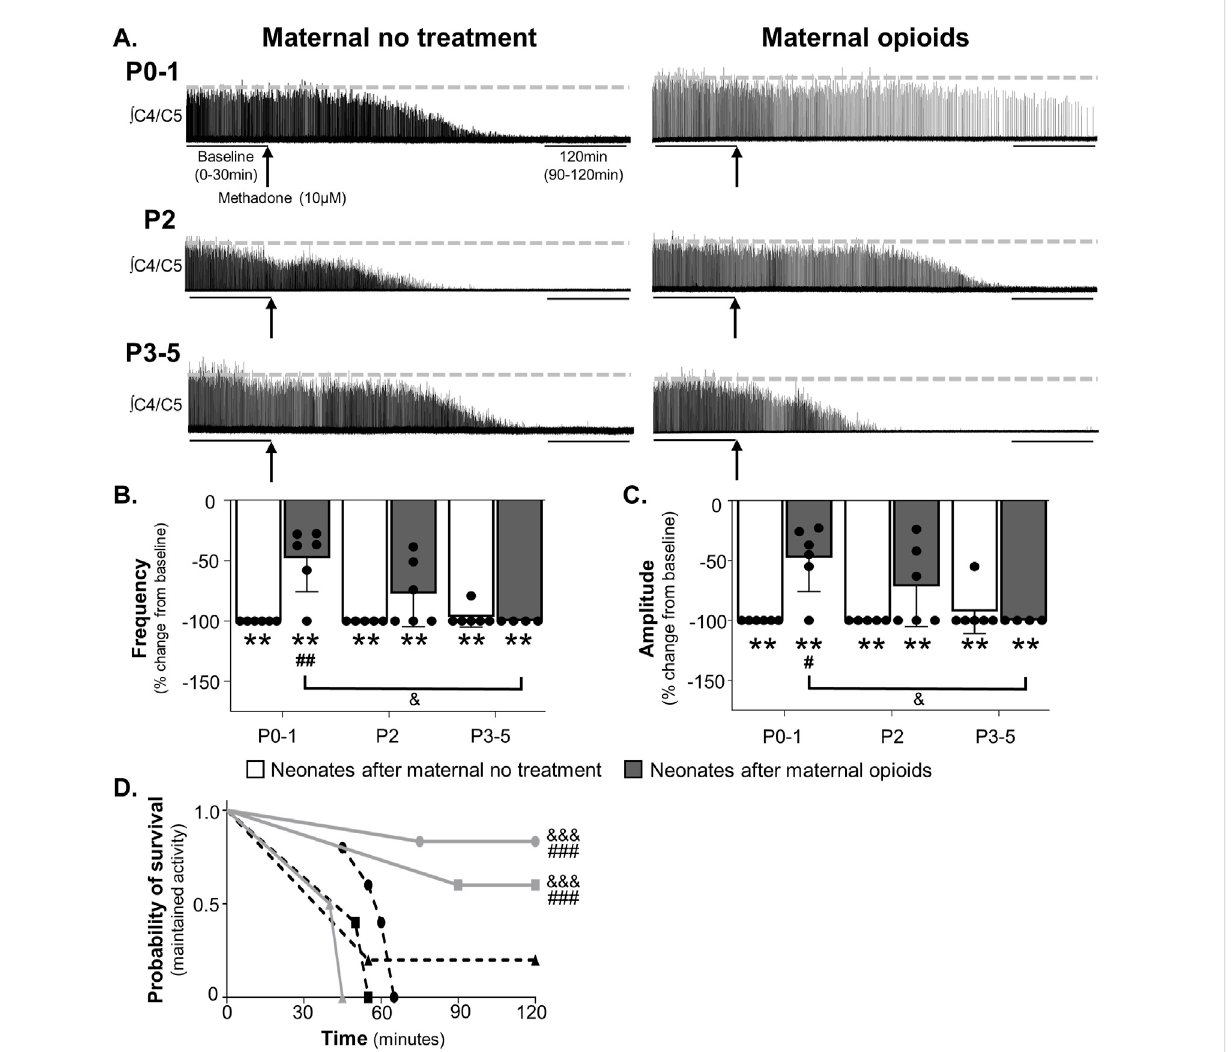
FIGURE 3 Neonates after maternal opioids age-dependently maintained respiratory activity after acute opioids. Representative neurograms from isolated brainstem-spinal cords (A) show respiratory activity was abolished with acute opioids (arrow, methadone, 10 µM, bath application) in neonates after maternalnotreatmentatallages,maintainedinP0-1neonatesaftermaternalopioids,andabolishedinolderneonates(P2orP3-5)aftermaternalopioids. Respiratory burst frequencies (B) and burst amplitudes (C) were abolished in neonates after maternal no treatment at all ages and decreased from baseline in neonates after maternal opioids at all ages. Respiratory burst frequencies and amplitudes were maintained in P0-1 neonates after maternal opioids compared to neonates after maternal no treatment at all ages and older neonates (P3-5) after maternal opioids, but not P2 neonates after maternal opioids. The probability of maintaining respiratory activity after acute opioids (D) was greater in P0-1 (circles) and P2 (squares) neonates after maternalopioids(graylines)thanolderneonatesP3-5(triangles)aftermaternalopioidsandneonatesaftermaternalnotreatment(dottedlines)atallages (** p < 0.001differentfrombaseline; # p < 0.05, ## p < 0.001, ### p < 0.0001differentfromneonatesaftermaternalnotreatmentatallages; & p < 0.05, &&& p < 0.0001 different from neonates after maternal opioids at P3-5; Three-way ANOVA; Bonferroni post-hoc